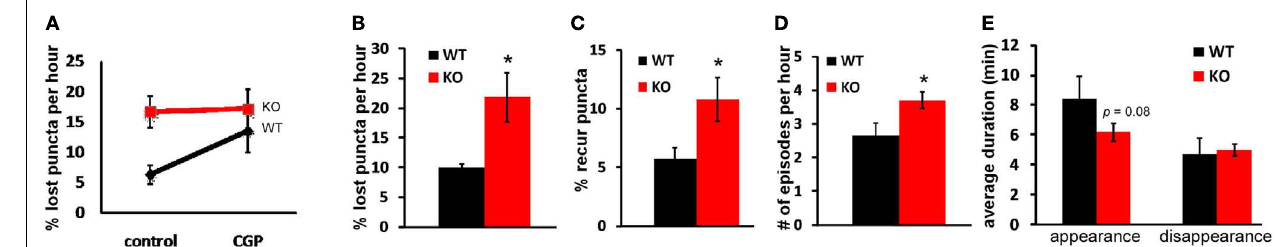
labeled by co-transfection of LSL-syn-GFP and LSL-DsRed constructs and their axons were imaged under control condition.The percentage of lost puncta was quantified ( n = 5 cells for both, t -test P = 0.03). (C) For neurons imaged in (B) , the percentage of recur puncta (see Materials and Methods) was quantified ( n = 5 cells, t -test P = 0.04). (D) For neurons imaged in (B) , the number of episodes for each recur puncta was analyzed ( n = 5 cells, t -test P = 0.03). (E) For all the observed episodes, the duration of appearance and disappearance were quantified ( n = 129 puncta for KO; n = 45